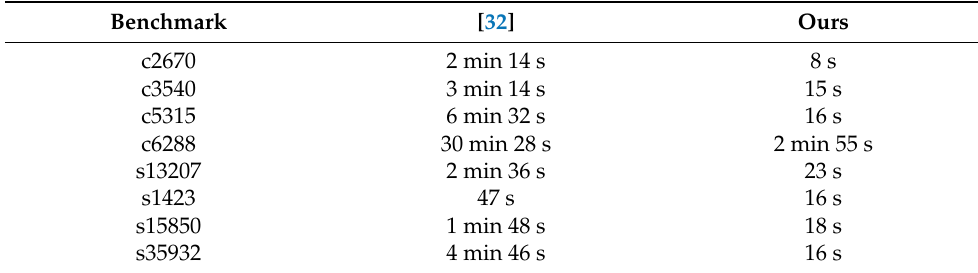
Table 4. Average time of each type of